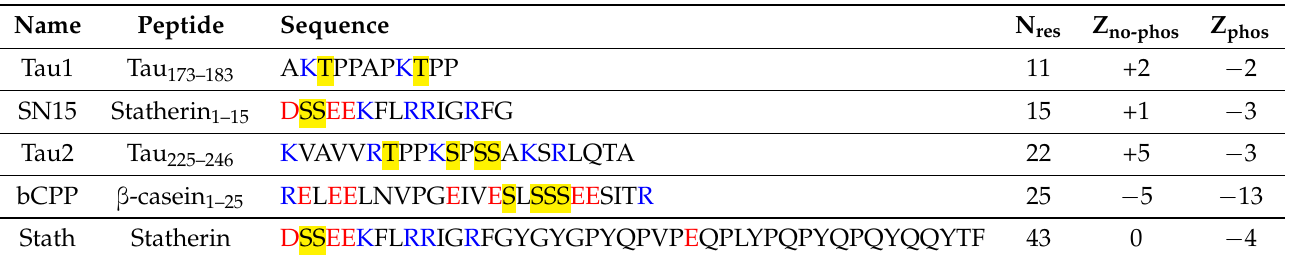
Table 1. Full name and sequence of the peptides included in this study. Positively charged residues are marked in blue, negatively charged in red, and phosphorylation sites are highlighted with yellow. The number of residues (N res ), net charge of the non-phosphorylated variant (Z no-phos ), and the phosphorylated variant (Z phos ) are also shown.